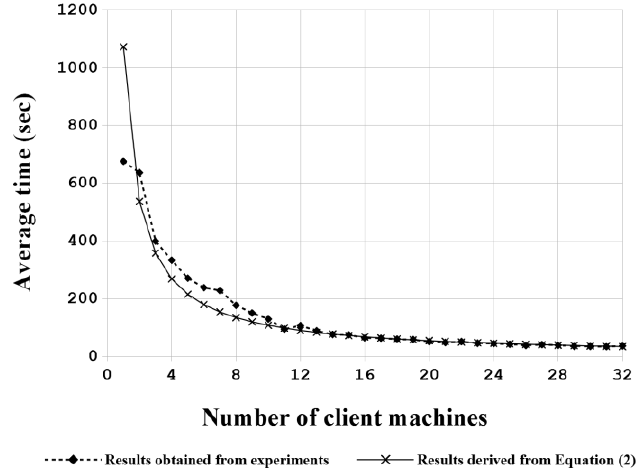
Figure 11. The speedup factors achieved by (a) the proposed BT solution and ( b ) the traditional multicast solution.